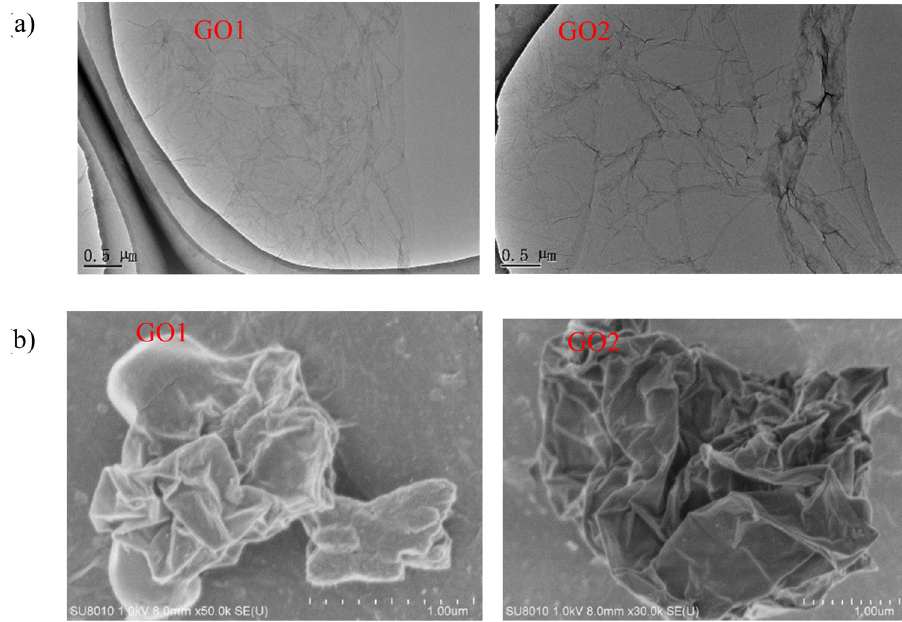
Figure 3: TEM ( a ) and SEM ( b ) images of GO1 and